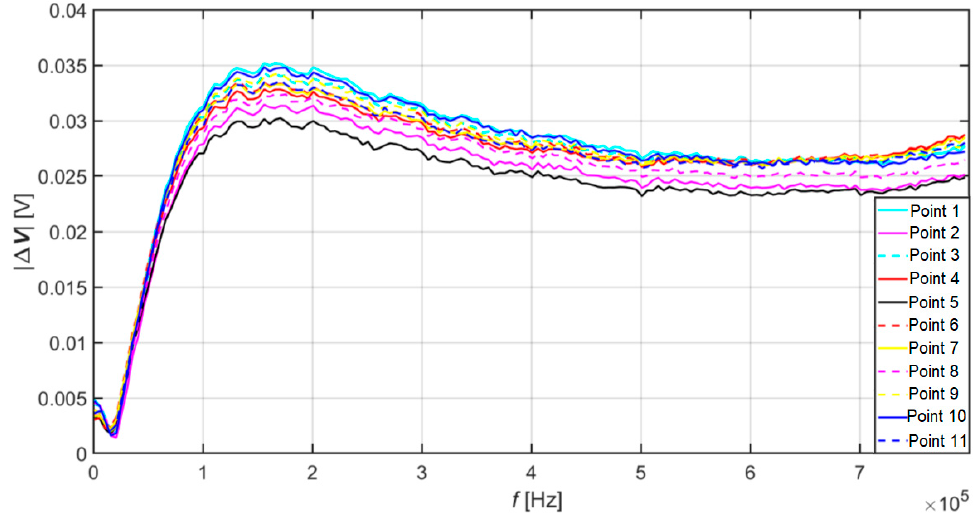
Figure 9. Graph of the absolute value of the voltage phasor of Specimen 5 corrosion crack.